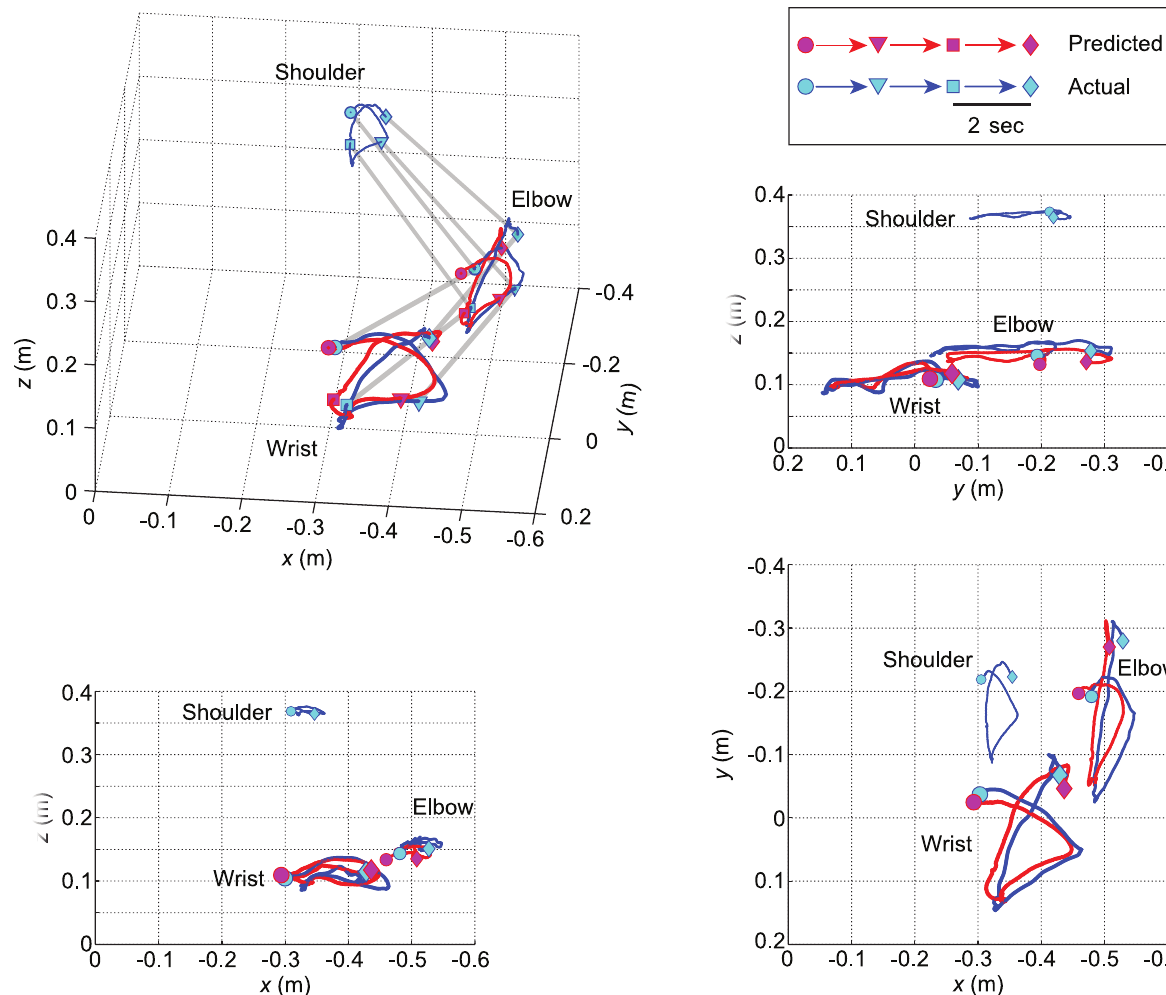
Figure 5. Examples of the predicted (red lines) and actual 3D trajectories (blue lines). A part of the 10th trial (6 s) in session 2 of patient 1 is shown (see Video S1). Markers (circles, triangles, squares, and diamonds) represent 2 s time intervals. Circles and diamonds indicate the earliest and the latest positions, respectively. The red trajectories were computed using predicted data q1 , q4 and patient 1 9 s actual arm length. The timings (positions of the markers) and trajectory curves of the predicted data were similar to those of the actual data.